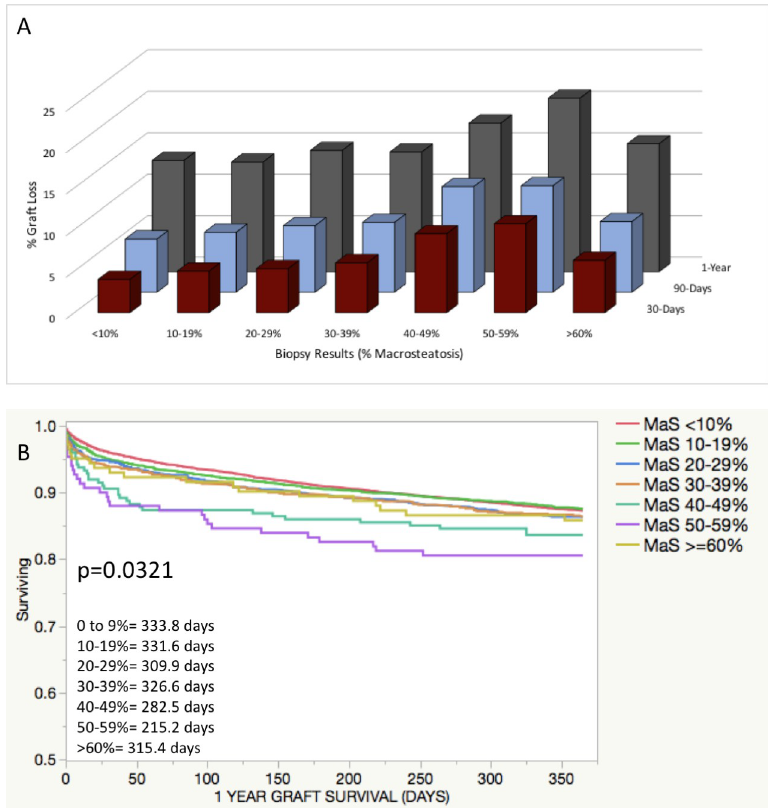
Fig 1. Allograft survival following donor liver biopsy by % macrosteatosis. Organs with donor liver biopsy were grouped by % MaS observed on biopsy. A) Incidence of graft loss is reported by MaS group at 30 days, 90 days and 1-year after transplant. P-value < 0.0001 assessed for each follow-up time point comparing across MaS groups. B) KM survival analysis performed for 1-year graft survival amongst all organs with donor liver biopsy, comparing MaS groups. Mean graft survival reported; all graft survival to 365